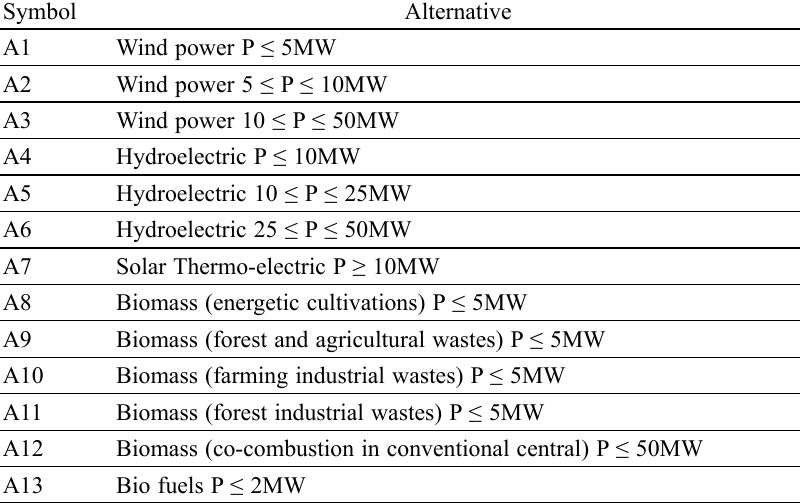
Table 2. Alternatives for electricity generation (Cristóbal 2011)